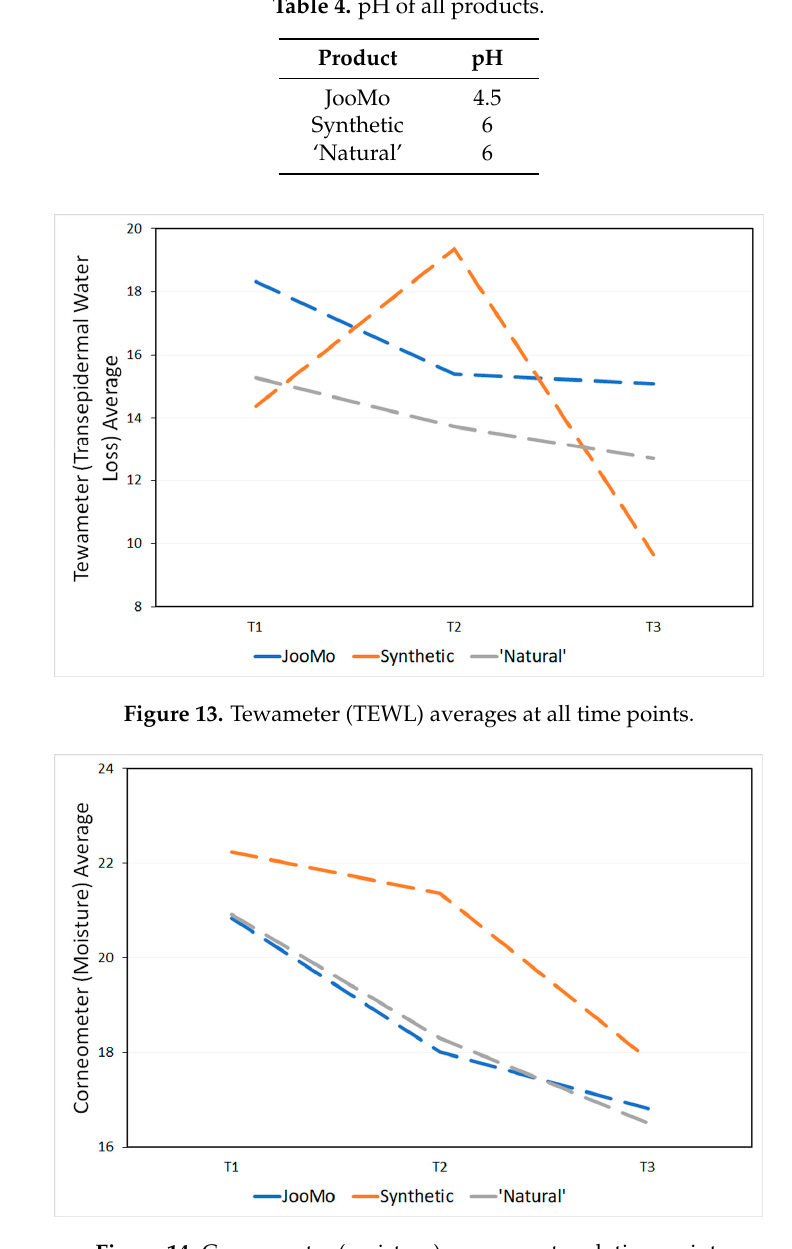
Figure 14. Corneometer (moisture) averages at each time point. Table 5. Average percentage change in TEWL for all product groups. Table 6. Average percentage change in moisture on the skin for all product groups.